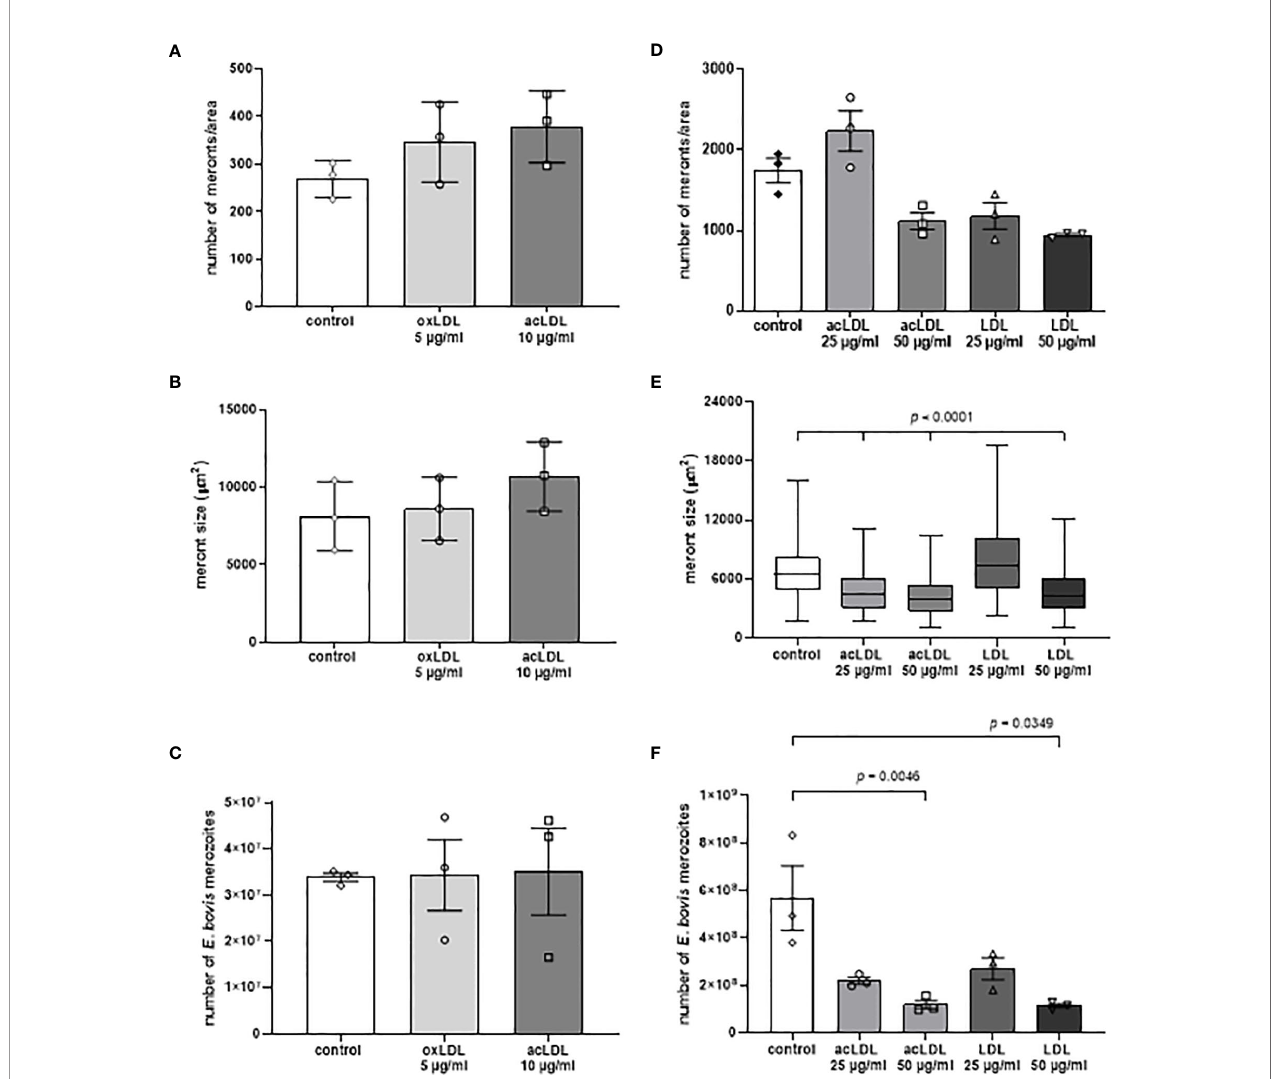
FIGURE 4 | Supplementation of LDL, aLDL and oxLDL failed to boost parasite replication. The effects of LDL, acLDL and oxLDL supplementation on E. bovis development were studied by estimating meront I numbers (A, D) and sizes (B, E) in addition to merozoite I numbers (C, F) . All treatments failed to signi fi cantly boost parasite replication. Three biological replicates; signi fi cance p < 0.05. Mean and standard